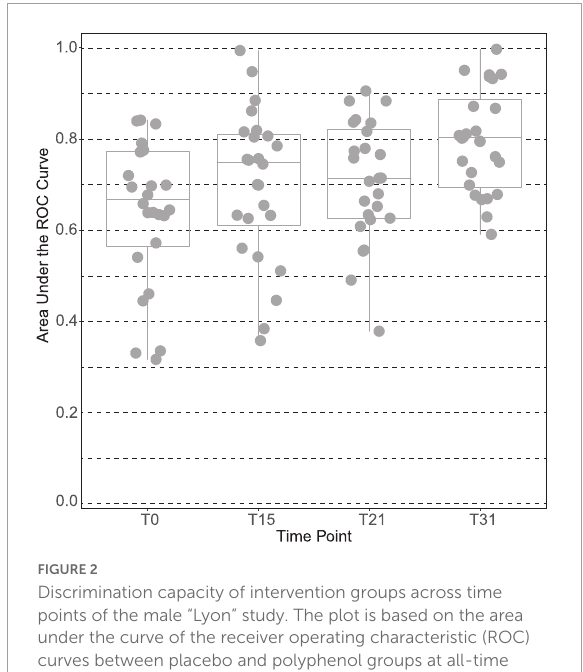
FIGURE2 Discrimination capacity of intervention groups across time points of the male “Lyon” study. The plot is based on the area under the curve of the receiver operating characteristic (ROC) curves between placebo and polyphenol groups at all-time points of the intervention: time point 0 (T0), at 15 days (T15), at 21 days (T21) and at the end, time point 31 days